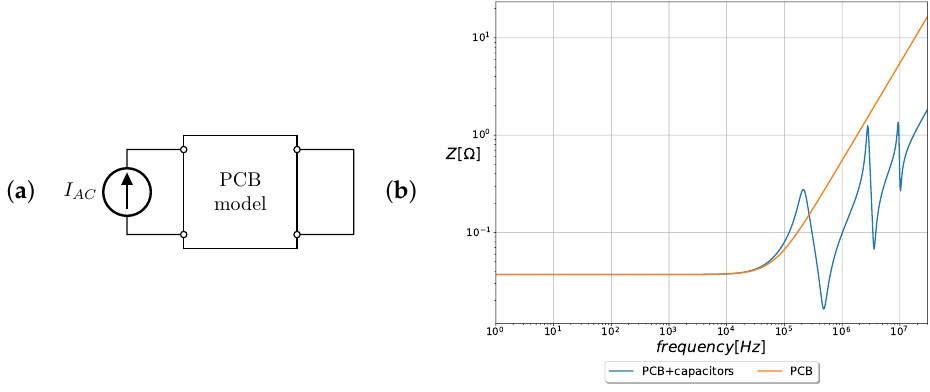
Figure 12. The models reduction based on impedance